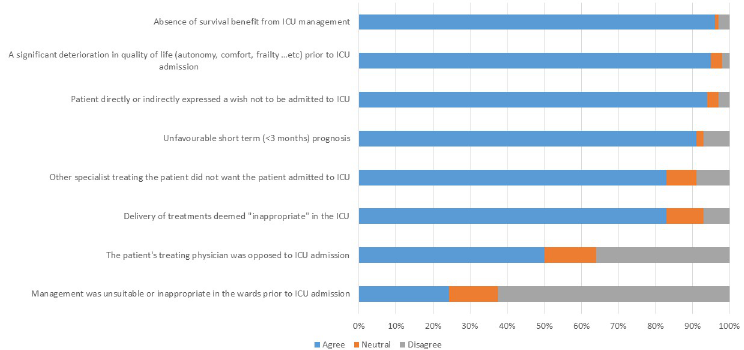
Fig 1. Level of reported agreement with the criteria used to qualify an ICU stay as “non-beneficial” (Domain 1 of the questionnaire).